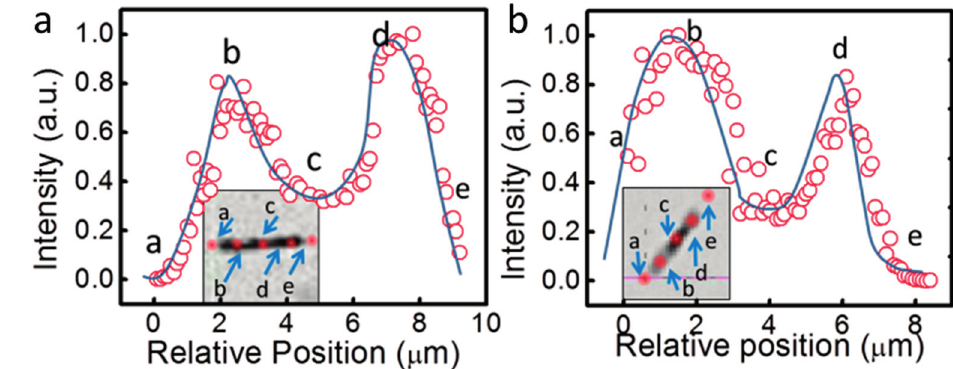
Figure 12. ( a ) Ni embedded and ( b ) Pt embedded hollow nanotubes. With permission from